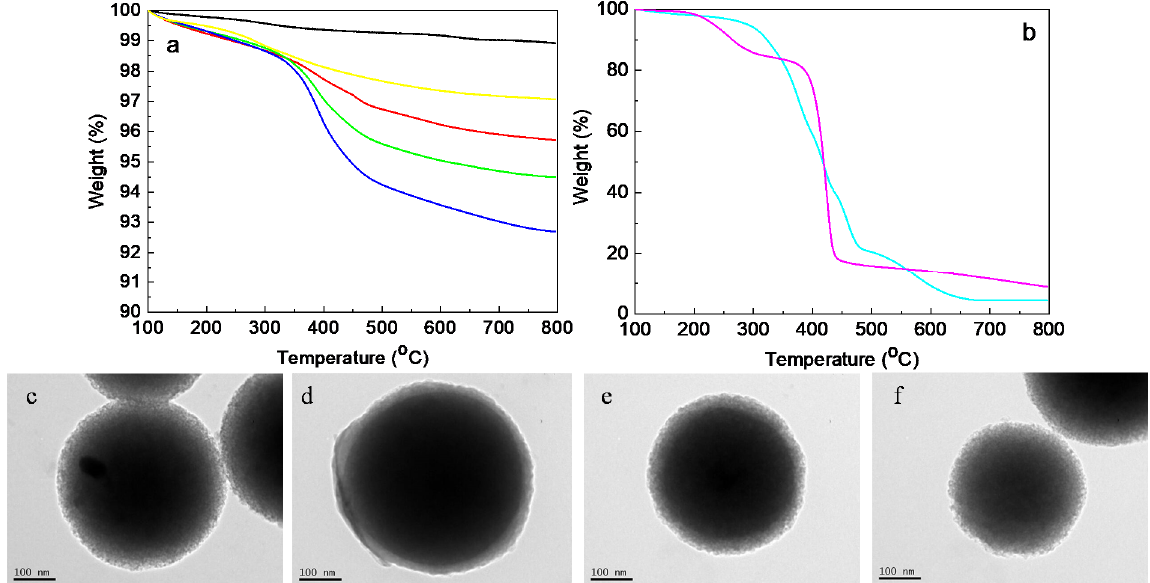
Figure 1. ( a ) Thermogravimetric analysis (TGA) analysis of bare SiO 2 (black line), SiO 2 @poly(allylamine hydrochloride) (PAH) (yellow line), SiO 2 @/PAH/organic natural polymer sodium alginate (NaALG)-g (red line), SiO 2 @PAH/NaALG- g/PAH (green line) and SiO 2 @PAH/NaALG-g/PAH/NaALG-g (blue line). ( b ) TGA plots of the PAH (cyan line) and NaALG-g (magenta line) polyelectrolytes. TEM images of SiO 2 @PAH ( c ), SiO 2 @PAH/NaALG-g ( d ), SiO 2 @PAH/NaALG- g/PAH ( e ) and SiO 2 @PAH/NaALG-g/PAH/NaALG-g ( f ) particles.